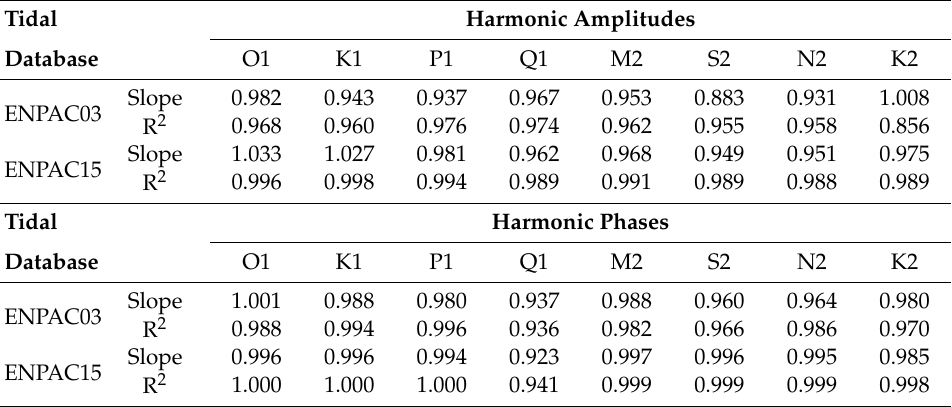
Table 6. Summary of best-fit linear statistics for the 165 common validation stations in the ENPAC03 and ENPAC15 tidal